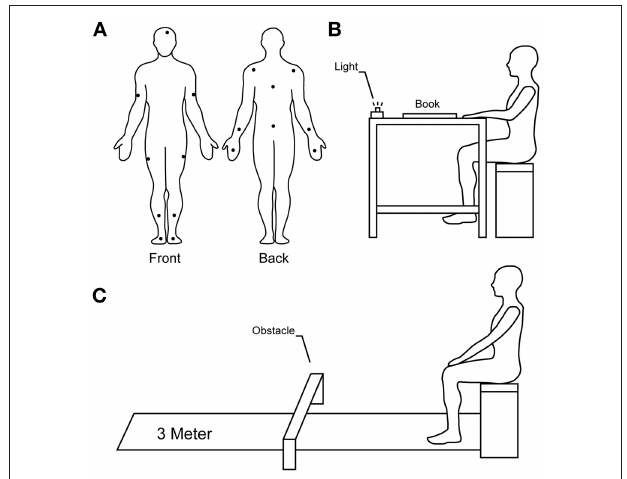
FIGURE 1 | Sensors placement and spatial schematics of the experimentation. (A) Diagram illustrating the position of inertial sensors on the body of participants. (B) Starting position of sitting ADL. (C) Starting position of TUG